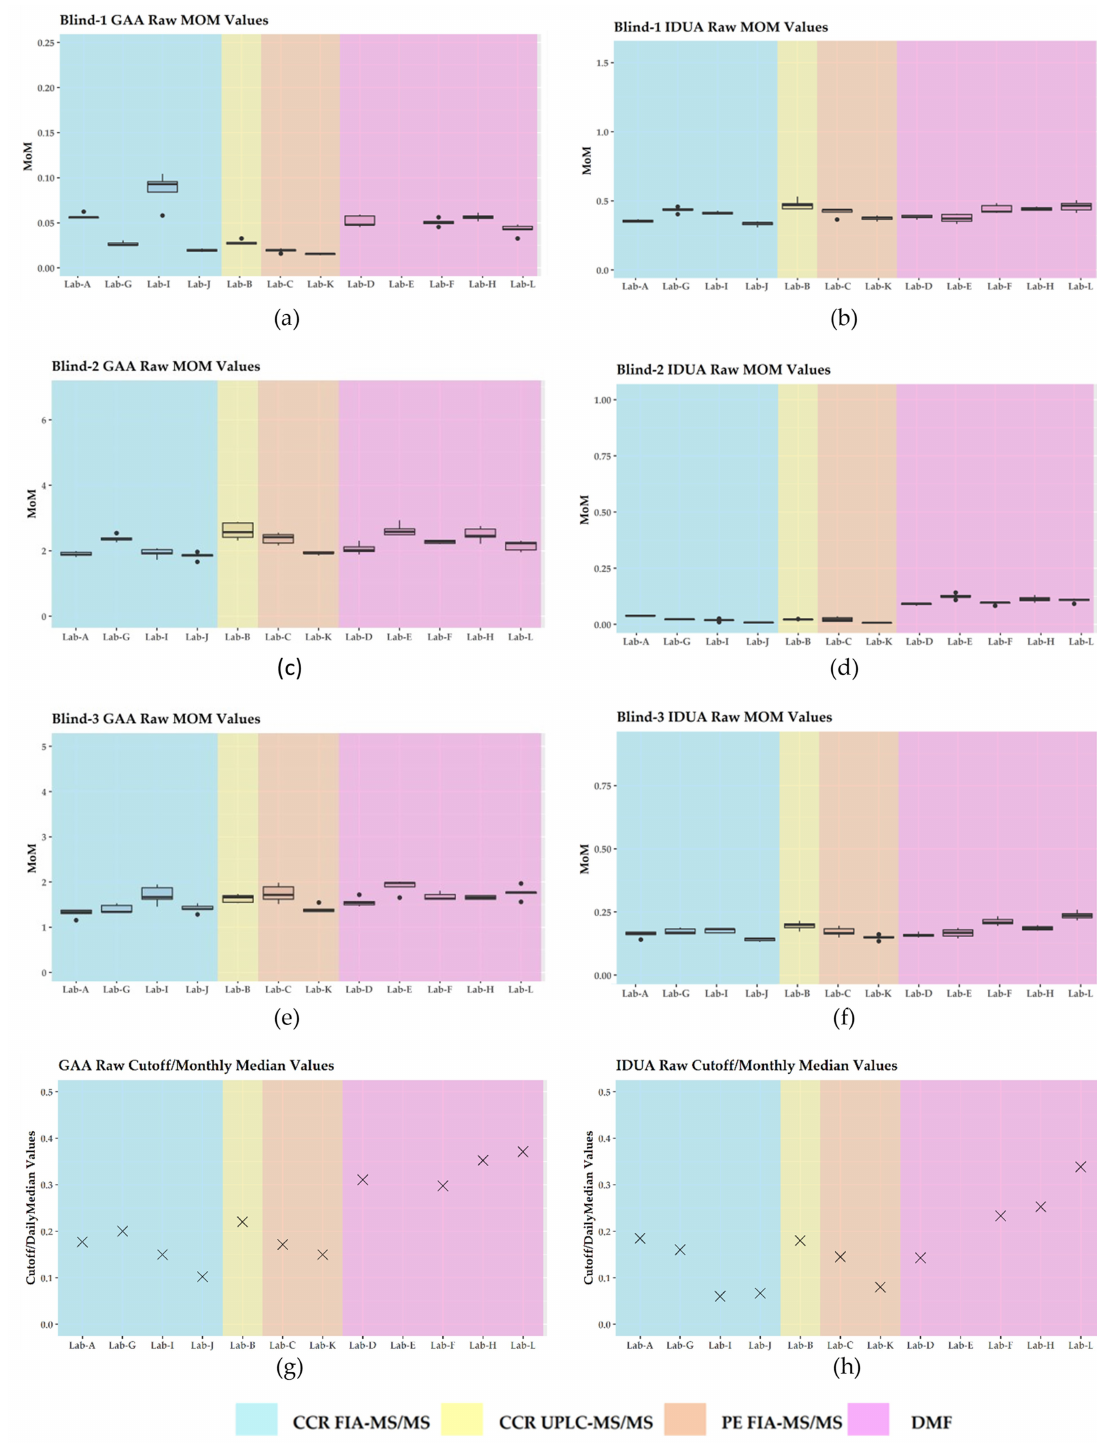
Figure A1. Plots for monthly MoM by laboratory: ( a ) deficient GAA enzyme activity specimen; ( b ) normal IDUA enzyme activity specimen; ( c ) normal GAA enzyme activity specimen; ( d ) deficient IDUA enzyme activity specimen; ( e ) normal GAA enzyme activity specimen; ( f ) low IDUA enzyme activity specimen; ( g ) GAA MoM cutoff; ( h ) IDUA MoM cutoff. (Note: we could not make a comparison between the daily MoM and monthly MoM for Lab E as we did not have sufficient